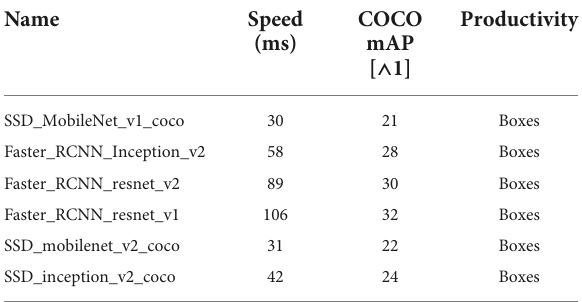
TABLE 1 Common pre-trained